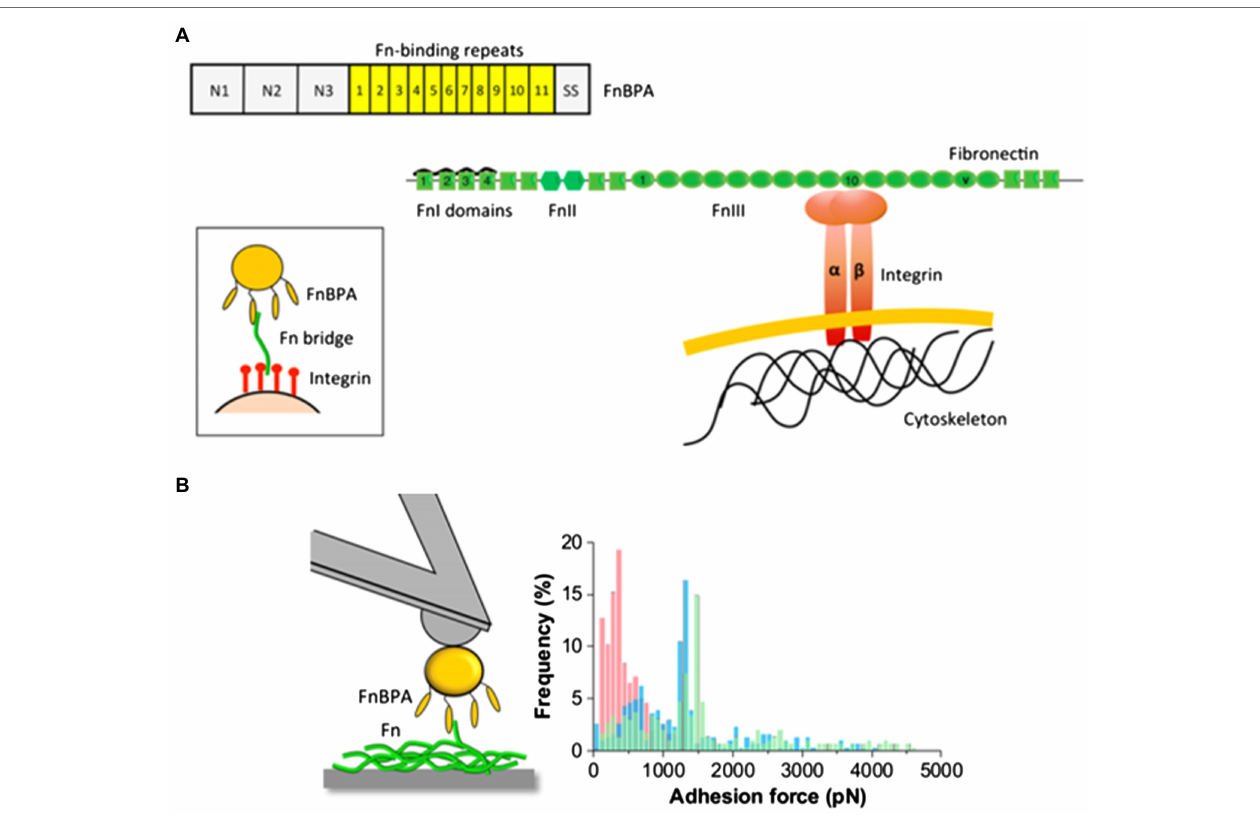
FIGURE 10 | The three-component FnBPA-fibronectin-(Fn)-integrin system. (A) Mechanism of FnBP-dependent cell invasion by S. aureus . The main invasion pathway of S. aureus involves interaction of the Fn-binding repeats of FnBPA with type I Fn modules via a tandem β -zipper structure. This triggers a conformational change in Fn, resulting in the exposure of the cryptic integrin-binding site in the tenth FnIII module, which in turn engages in a high-affinity interaction with the α 5 β 1 integrin found on the membrane of mammalian cells. (B) Maximum adhesion force histograms obtained by recording force-distance curves between S. aureus cells and Fn immobilized on solid substrates. This figure is adapted with permission from Prystopiuk et al.